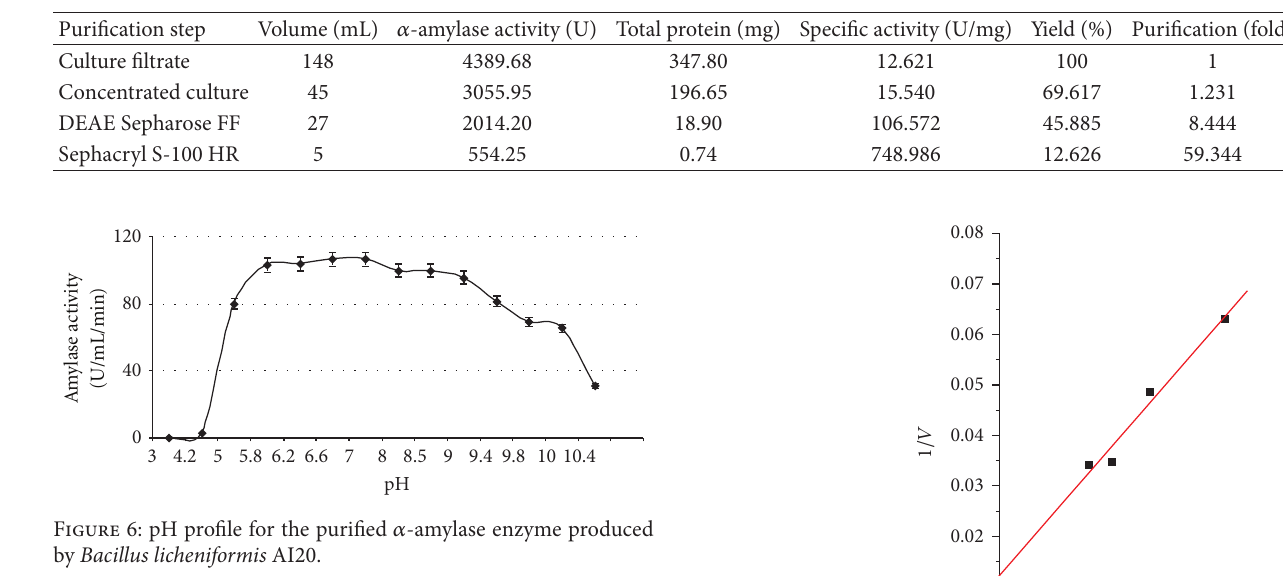
F 8: Lineweaver-Burk plot for the puri�ed produced by Bacillus licheniformis